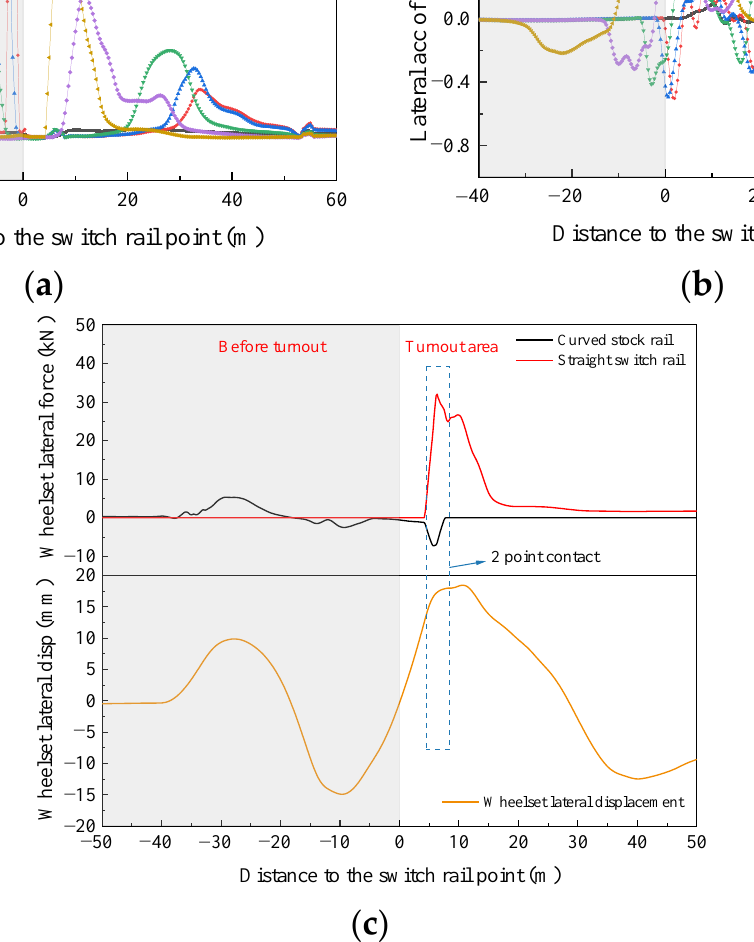
Figure 12. Variations along the distance in the dynamic indicators under the AL in front of the turnout: ( a ) Wheelset lateral force; ( b ) Lateral acceleration of the vehicle body; ( c ) Comparison of the wheelset lateral force and wheelset lateral displacement.